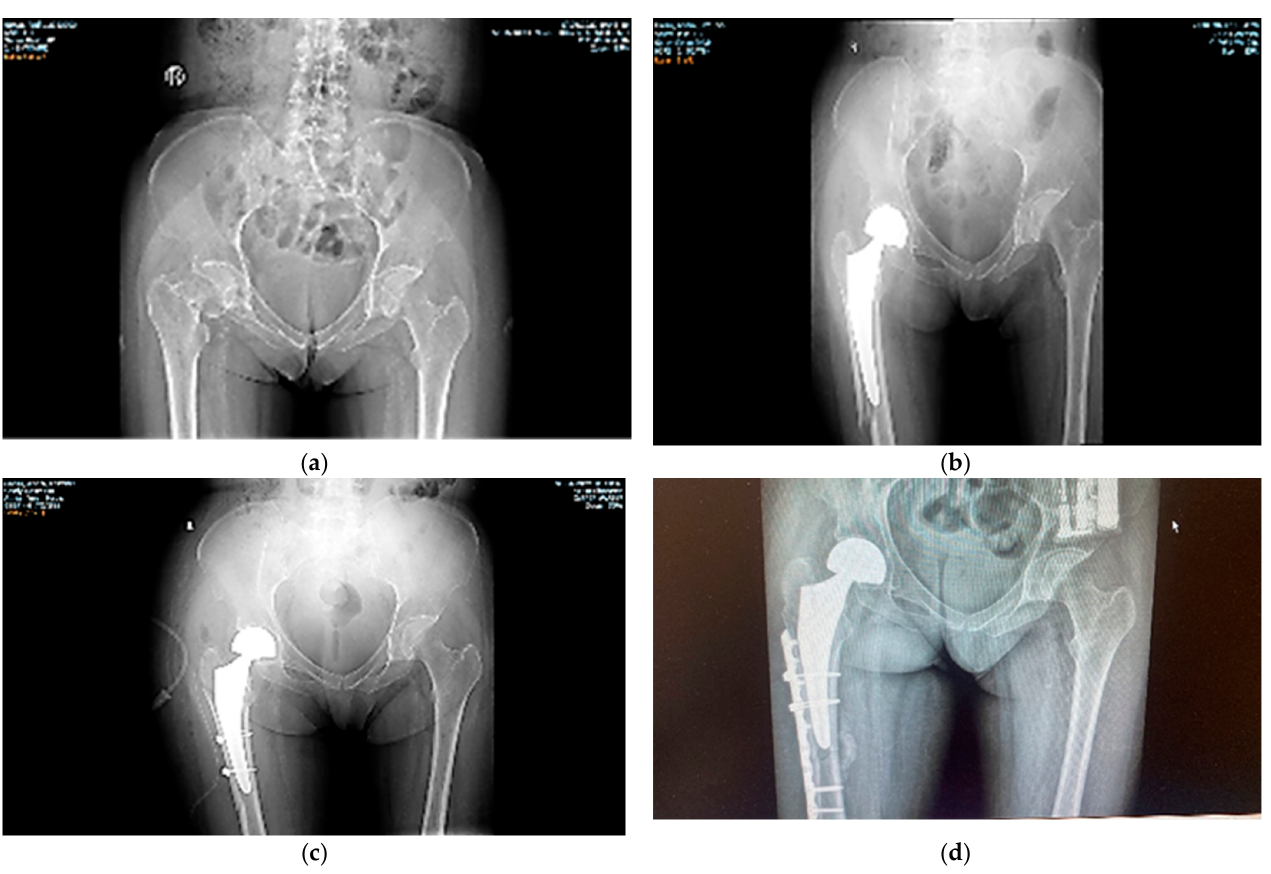
Figure 4. Case 2. ( a ) The bilateral femoral neck fractures are well defined. The patient suffers from type I diabetes and is also dependent on dialysis. ( b ) The R fracture is reduced with a Taperloc prosthesis, but the femur cracked during insertion of the prosthesis and supplementary cables were required to fix the bone ( c ). ( d ) shows the final result, i.e., complete reduction in the fracture in the R femur one month after the first surgery, when the patient returned to the clinic with a new fracture on the same side. The strongest sources for such an enhanced frailty of the bone are presumably her metabolic diseases (see also refs. [5,10–14,20–23]).